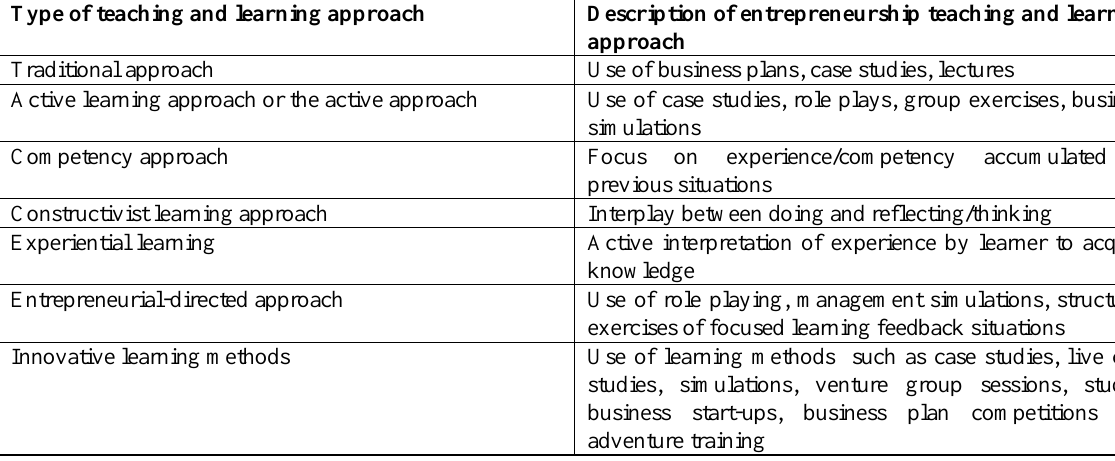
Table 1: A brief synopsis of the different entrepreneurship teaching and learning approaches Type of teaching and learning